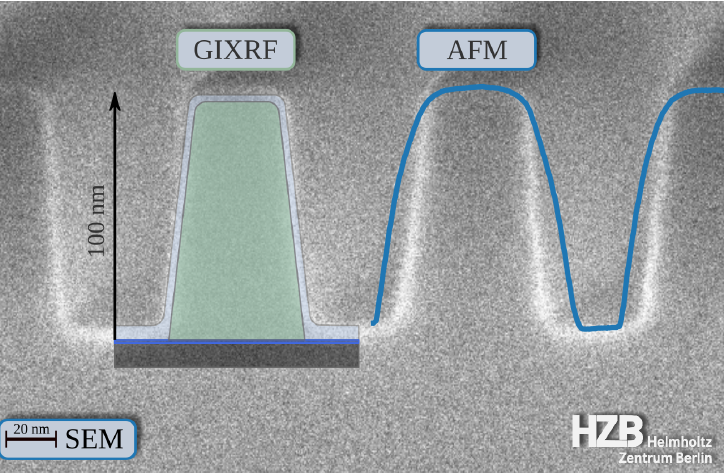
Figure 6. Comparison of the AFM data with the result of the GIXRF reconstruction and an SEM picture from a witness